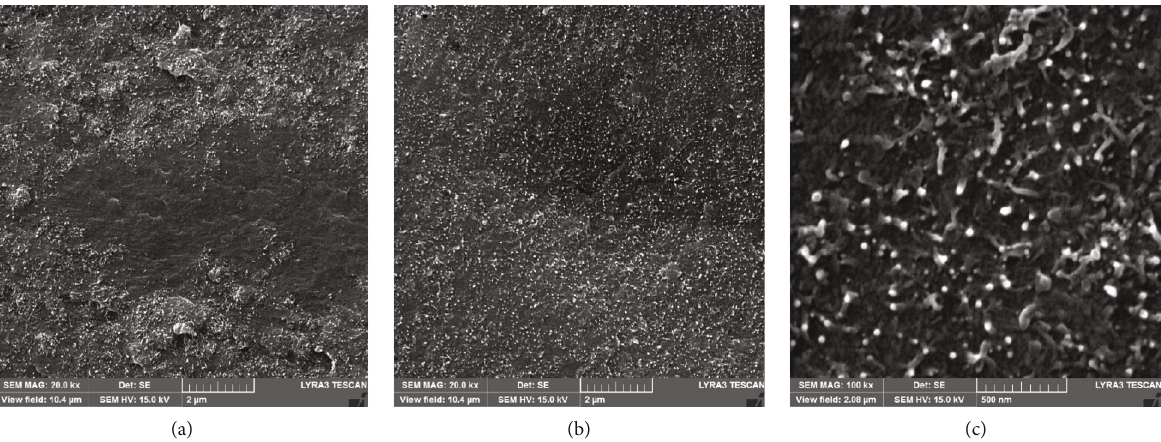
Figure 1: SEM images of PET/CNT masterbatch (a) and the nanocomposite with 5wt. % CNT content (b,